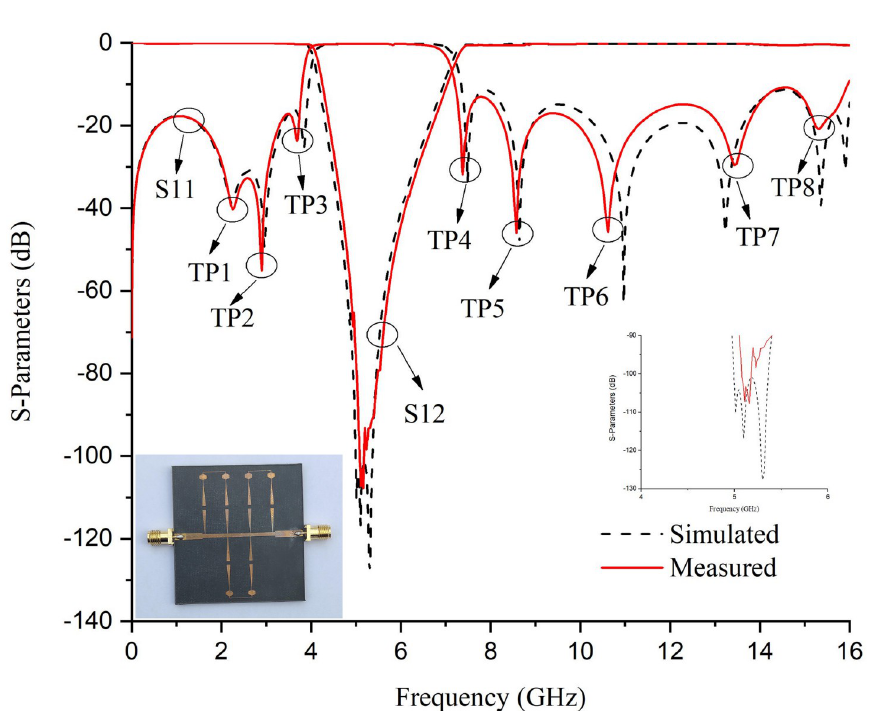
Fig 13. S-Parameter response of the fabricated third-order BSF.